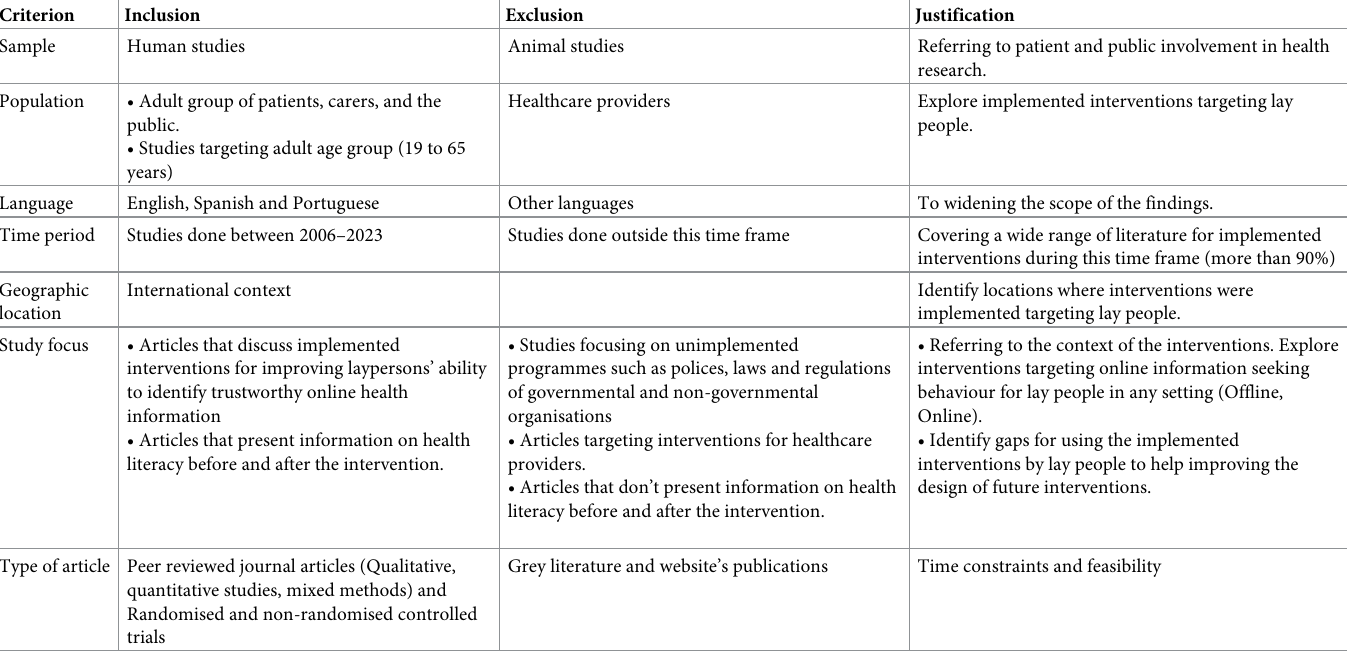
Table 1. Inclusion and exclusion criteria with